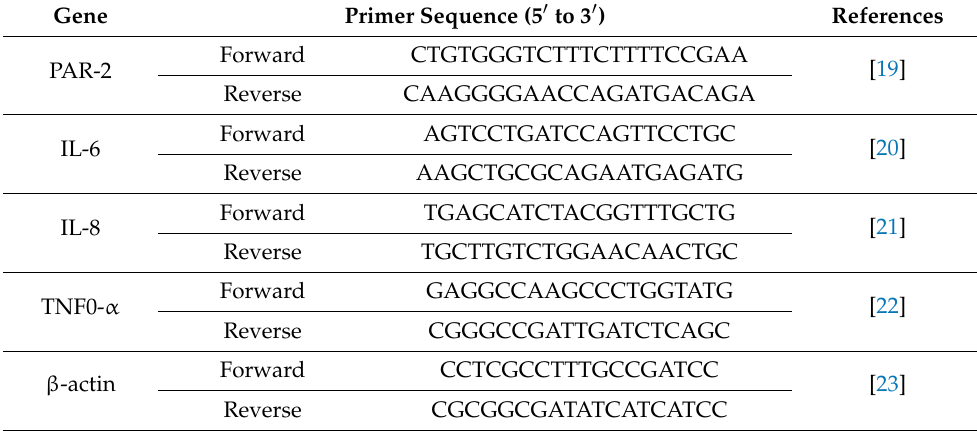
Table 1. Primer sequences of genes analyzed by quantitative real-time PCR. Gene Primer Sequence (5 (cid:48) to 3 (cid:48)